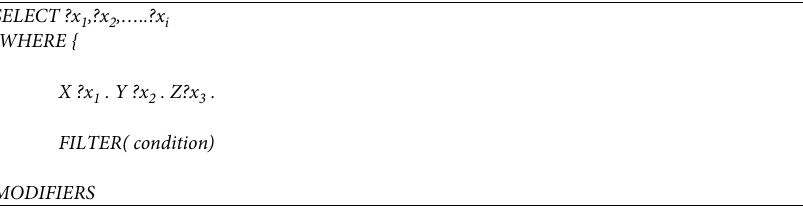
Figure 4: General dynamic